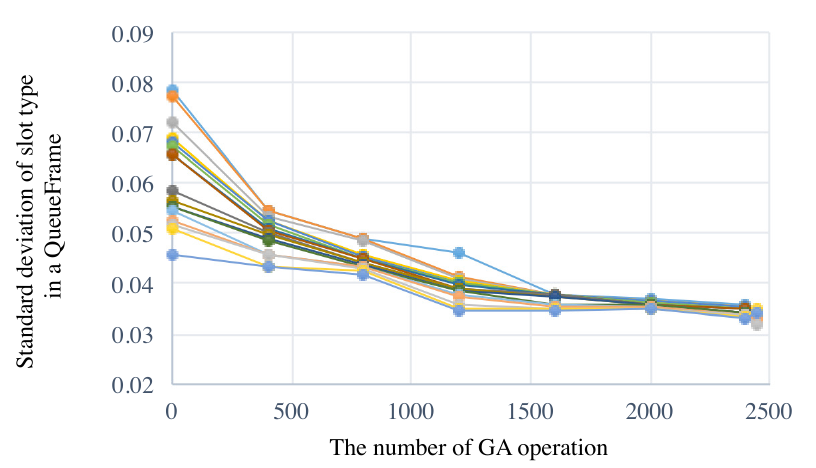
Figure 16. Transition of standard deviation slot type value of the top 20 individuals, where N all =